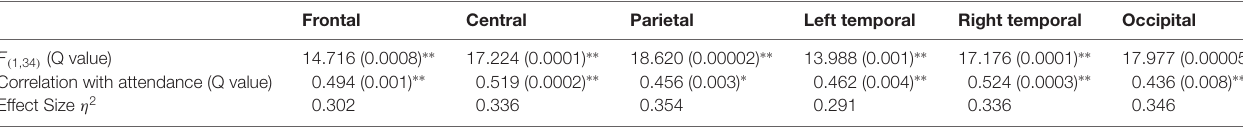
TABLE 2 | Results comparing individual alpha power during 4 min of guided meditation before and after mindfulness-based training (MBT) with FDR adjusted Q values.